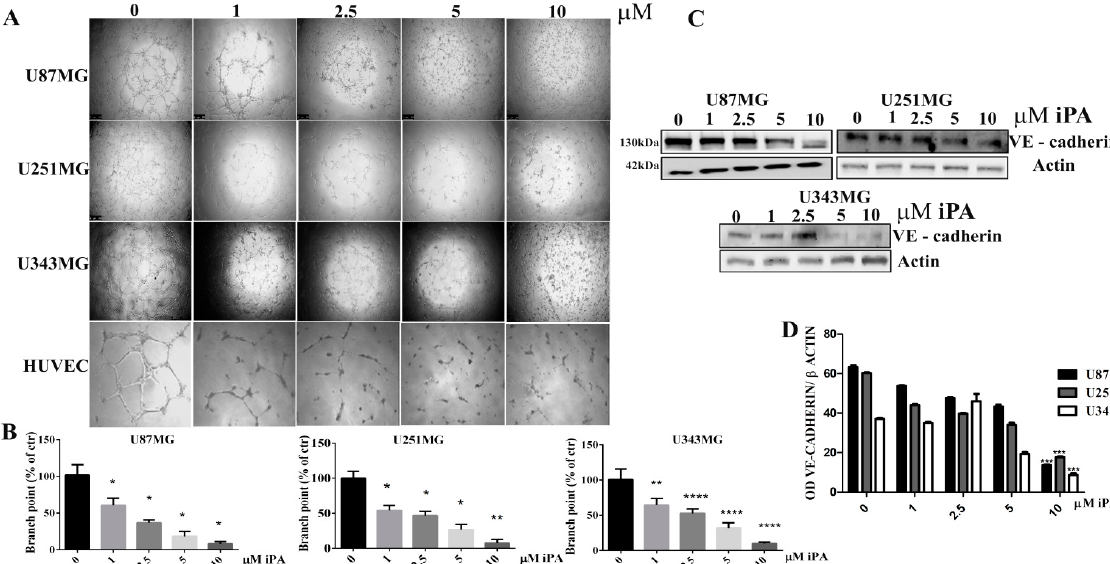
Figure 1. N6-isopentenyladenosine inhibits the tube formation in GBM stabilized cell lines. ( A ) Representative images of vascular tubes formed by cells in control group (DMSO) and in treated group at 18 h. iPA is used at several concentrations. Network of tubes, in each well, were analyzed directly under an inverted microscope with 4× phase contrast and imaged. Scale bars: 250 µm. ( B ) Quantification of vascular branching. Branch point (sites of intersection of at least three tubes) number in each well was counted. ( C ) Immunoblotting showing the effect of iPA on VE-cadherin in GBM stabilized cell lines. ( D ) Densitometric analysis of each Western Blot panel. Results are expressed as the mean ± SD of four independent experiments conducted in triplicate. (ANOVA, * p < 0.05, ** p < 0.01, *** p < 0.001, **** p < 0.0001).